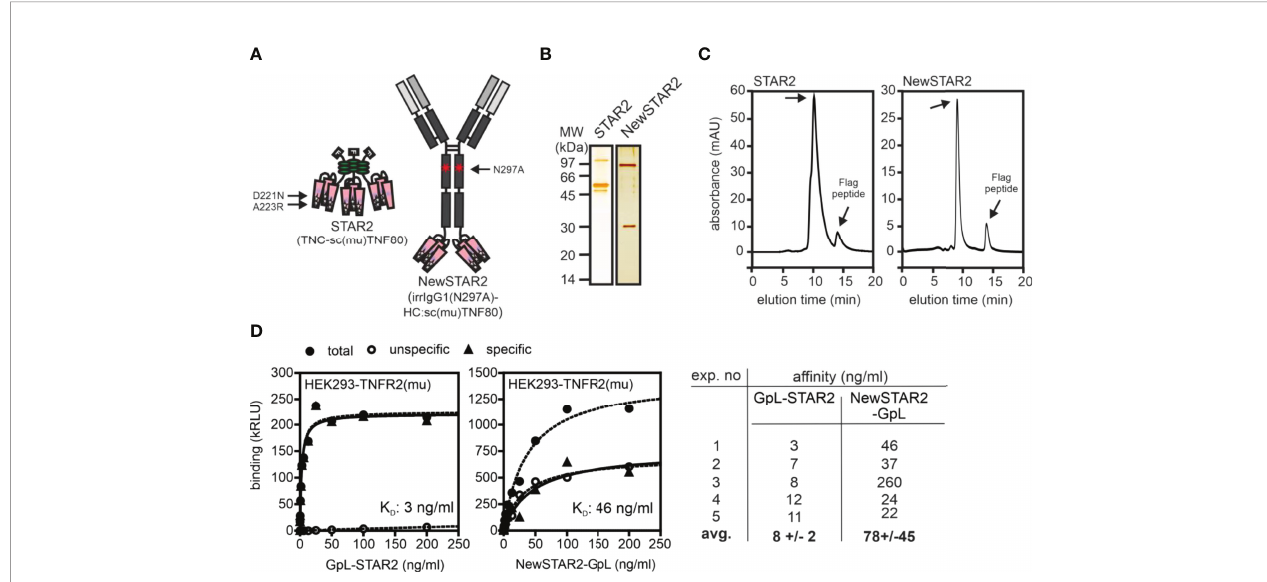
FIGURE 1 | Puri fi cation of TNFR2-selective TNF fusion proteins. (A) Domain architecture of STAR2 (TNC-sc(mu)TNF80) and NewSTAR2 (irrIgG1(N297A)-HC:sc(mu) TNF80). Please note, aa positions refer to full-length murine TNF (ac. no. AAC82484). (B, C) Proteins were puri fi ed by anti-Flag af fi nity chromatography and analyzed by (B) SDS-PAGE and (C) gel fi ltration. (D) Binding of GpL fusion proteins of STAR2 and NewSTAR2 to HEK293 cells transfected with empty vector or a murine TNFR2 expression plasmid. Speci fi c binding was calculated as the difference between total binding (TNFR2 transfectants) and unspeci fi c binding (empty vector transfectants). Left and middle panel: representative experiments; right panel summarizing table of 5 independent